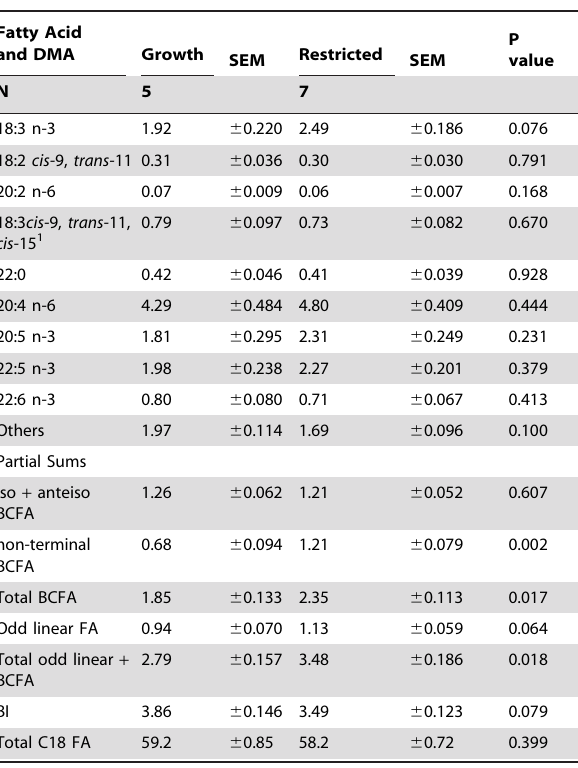
Table 3. Effect of feed restriction in total fatty acid (mg/g DM) and dimethylacetal and fatty acid composition (% of total products) of the gastrocnemius muscle in Damara ram